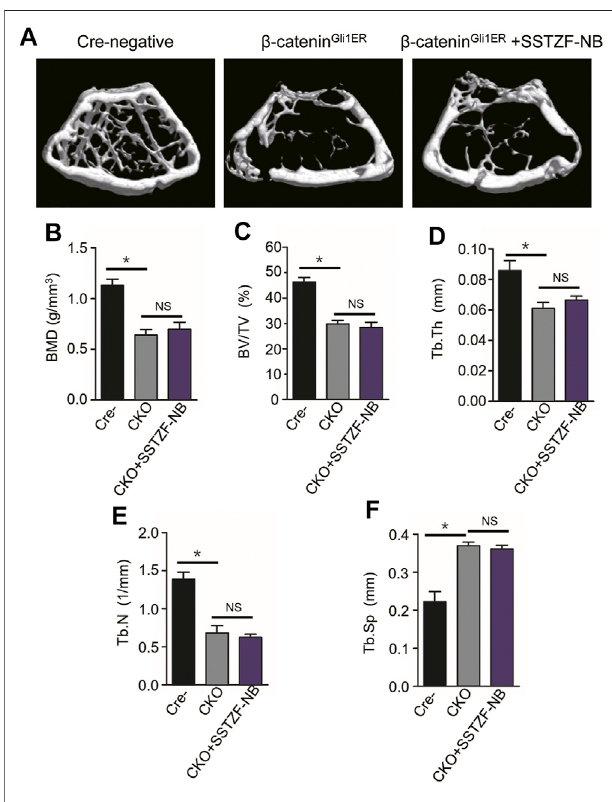
FIGURE 5 | The positive effect of SSTZF-NB preventing bone loss is blocked in β -catenin Gli1ER mice. (A) Representative μ CT image of each group. Quanti fi cation of microstructural data including BMD (B) , BV/TV (C) , Tb.Th (D) , Tb.N (E) , and Tb.Sp (F) . Cre-: Cre-negative mice group, CKO: β -catenin Gli1ER mice group, CKO + SSTZF-NB: β -catenin Gli1ER mice treated with SSTZF-NB group. NS: no signi fi cant difference. * p <